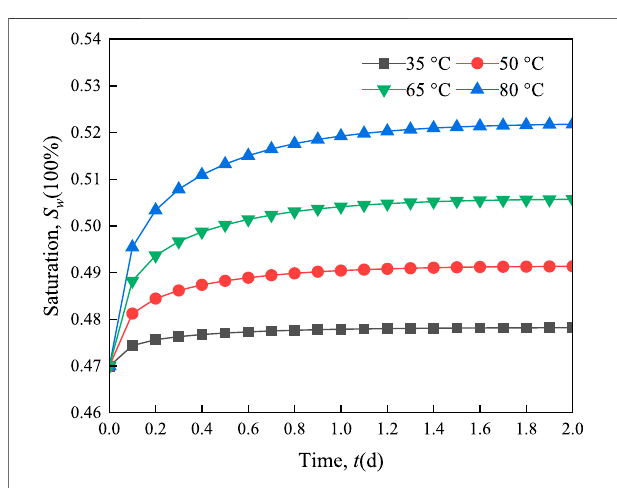
FIGURE 8 | Variation of saturation at B point with time under different heat source